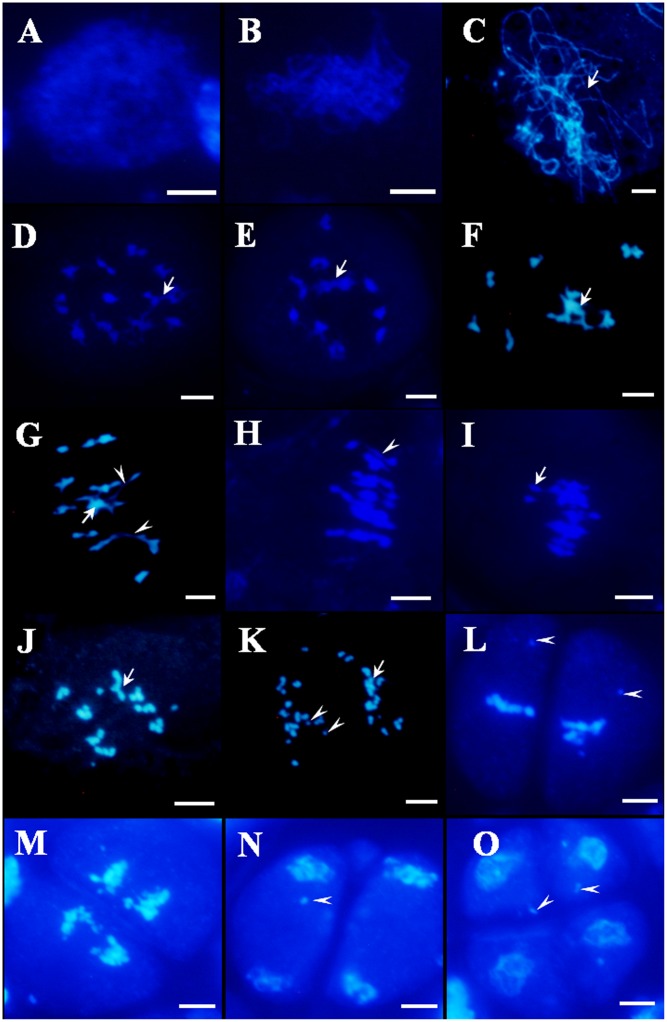
4′,6-diamidino-phenylindole-stained chromosome spreads of male meiosis in Osfignl1 plants. (A) Leptotene. (B) Zygotene. (C) Pachytene. (D,E) Diplotene. Arrows indicate entangled chromosomes. (F,G) Diakinesis. Arrows indicate multivalent chromosome and the arrowheads indicate chromosome bridges. (H,I) Metaphase I, showing chromosome bridges (arrowhead). Chromosomes did not align on the equatorial plate (arrow). (J,K) Anaphase I, showing chromosome fragments (arrowheads) and entangled chromosome (arrows). (L) Metaphase II. (M) Anaphase II. (N) Telophase II. (O) Tetrad. From Metaphase II (L) to tetrad (O), showing lagging chromosome (arrowheads). Bars = 5 μm.